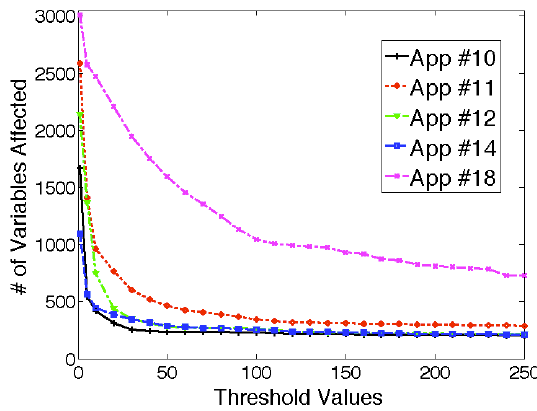
Figure 3: Number of variables affected by different apps’ interventions with different threshold